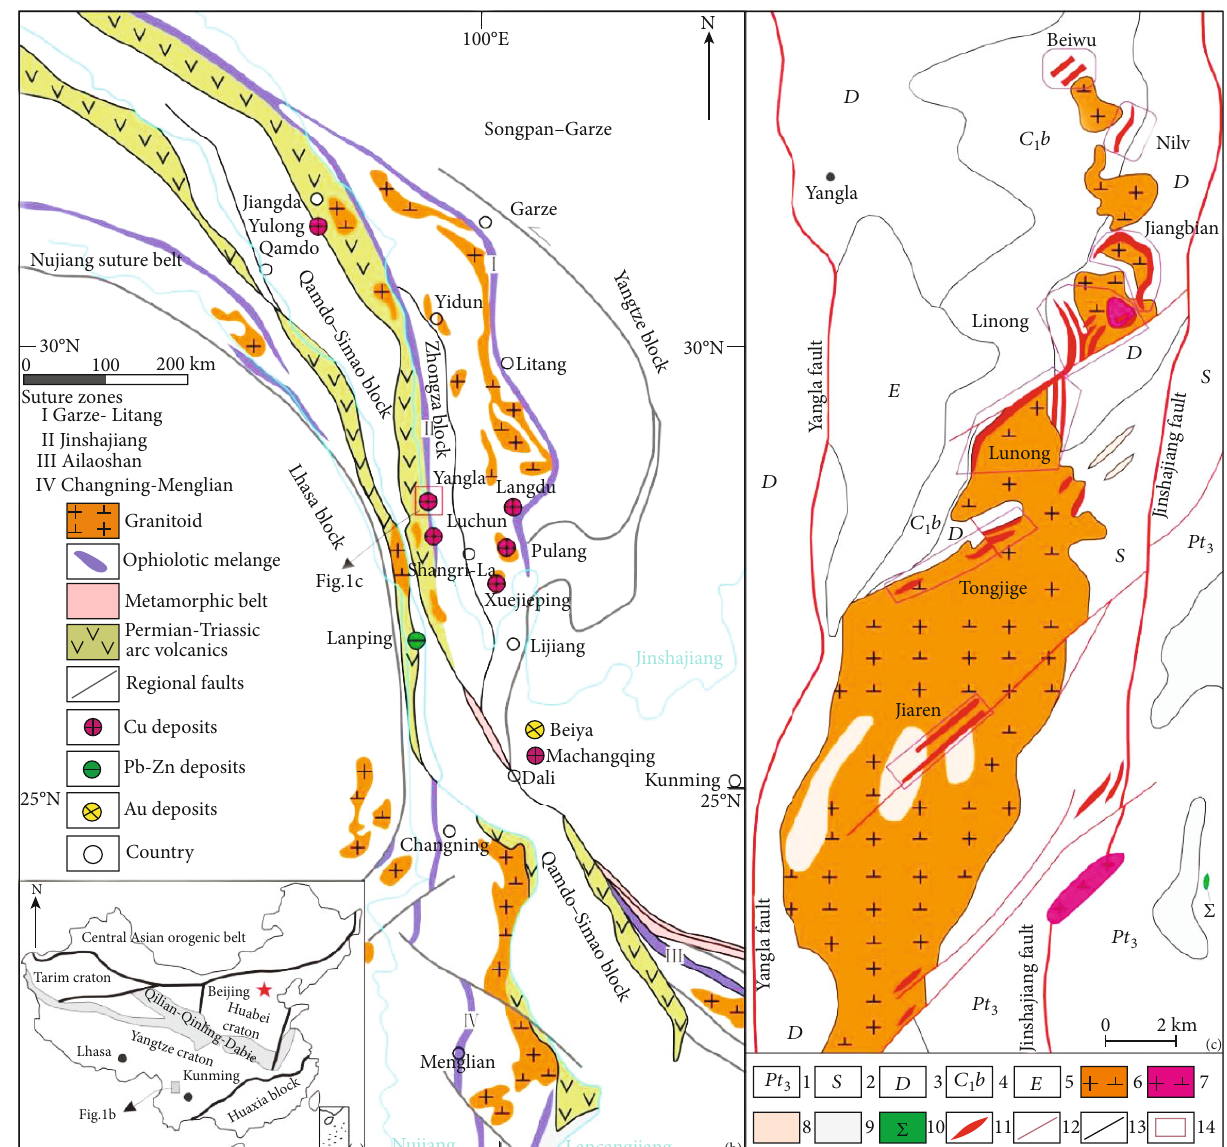
Figure 1: (a) Geotectonic framework map of China showing the location of the Sanjiang Orogen (after [2]). (b) Regional geological map of the Sanjiang region (SW China), showing the major geological terranes, suture zones, volcanic belts, and locations of the major ore deposits (modi fi ed after [3]). (c) Geologic map of the Yangla Cu deposit showing the distribution of the major ore-related intrusion, faults, ore block, and ore bodies (modi fi ed after [23]). 1 — Gajinxueshan Group, 2 — Silurian, 3 — Devonian, 4 — Carboniferous Beiwu Formation, 5 — Tertiary, 6 — granodiorite, 7 — granitic porphyry, 8 — monzonite granite, 9 — quartz-diorite, 10 — Hercynian (ultrabasic rock), 11 — ore body, 12 — faults, 13 — geological boundary, and 14 — ore